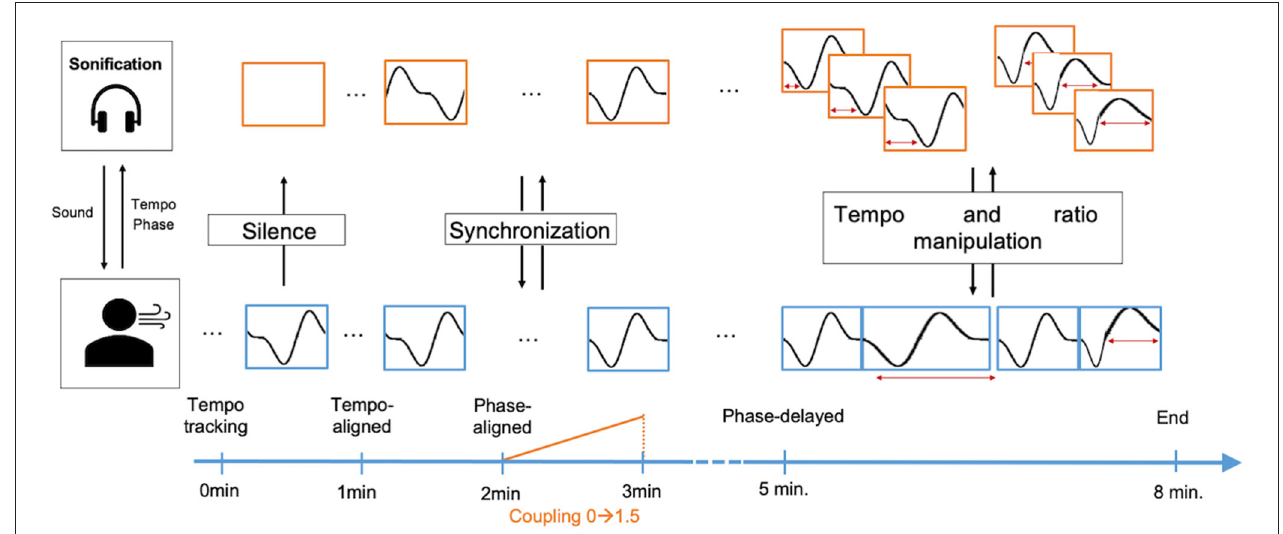
FIGURE 1 | Biofeedback alignment strategy of breathing tempo and breathing